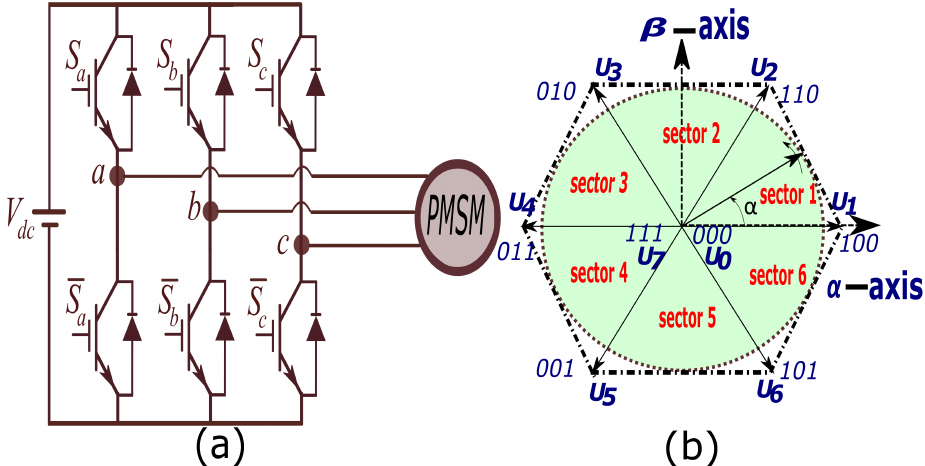
Figure 1. PMSM drive system: ( a ) Two-Level voltage source inverter. ( b ) Voltage